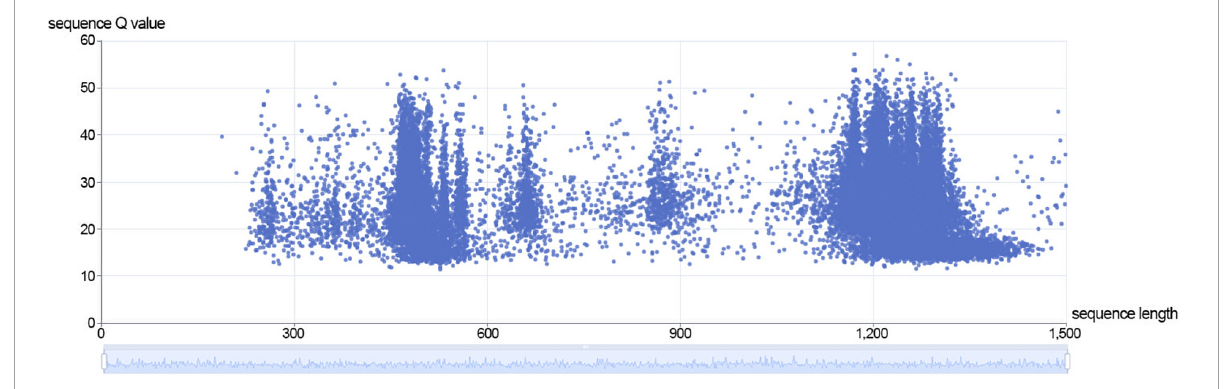
FIGURE3 The distribution of sequence length and sequence Q value of duplex data in method A.